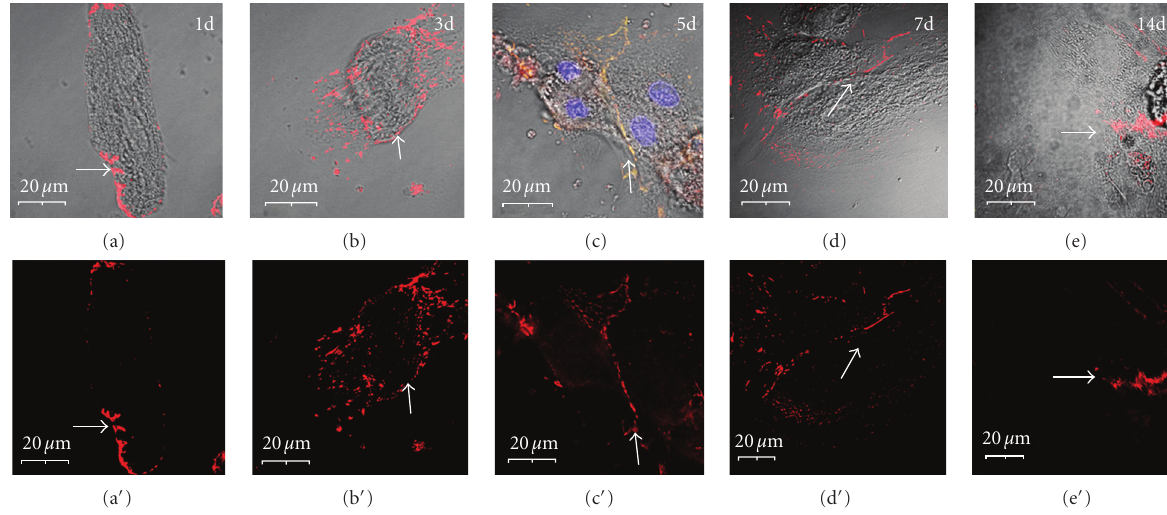
Figure 1: Reassembly of cell-cell contacts in remodeling adult rat cardiac myocytes in culture. (a, b) On days 1–3 post plating, the cell rounds up, the IDs disassemble, and cadherins redistribute along the periphery of the cell (arrow in b). (c, d) Between days 5–7, new cell-cell contacts form and cadherin localizes to specific domains along the line of apposition (arrows). (e) By 14 days post plating, the cell-cell contacts have remodeled to form more localized and mature structures (arrow). Scale bars are 20 μ m.